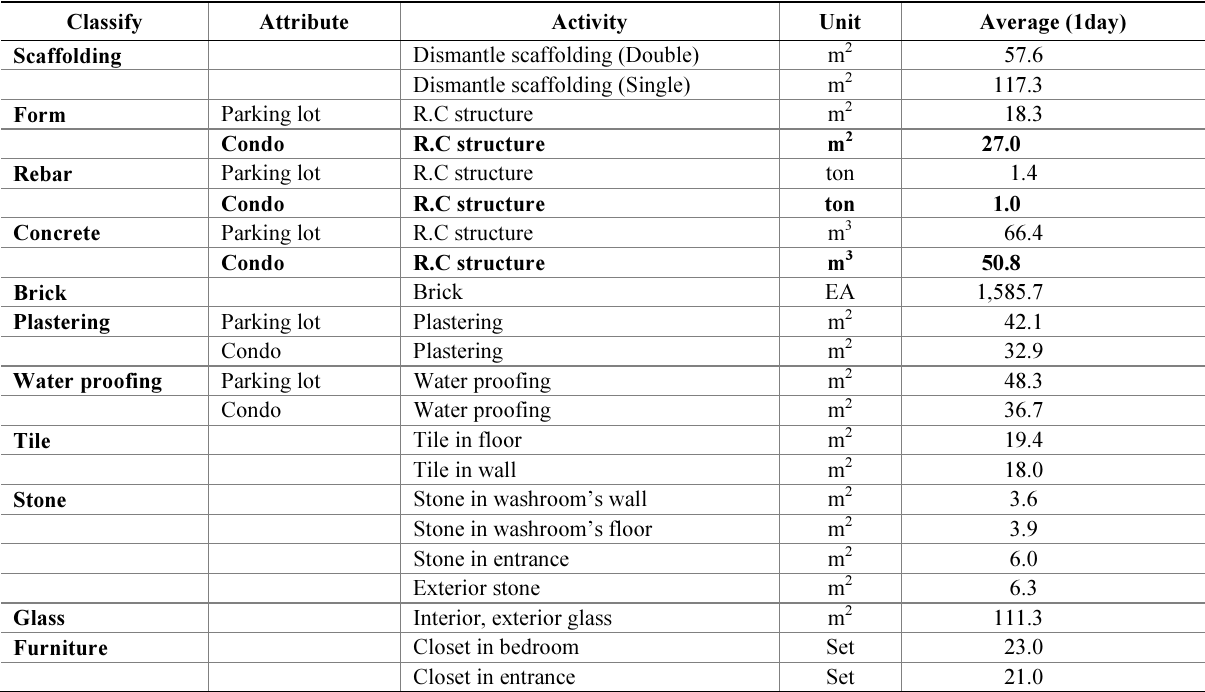
Table 1. Manpower productivity in condominium